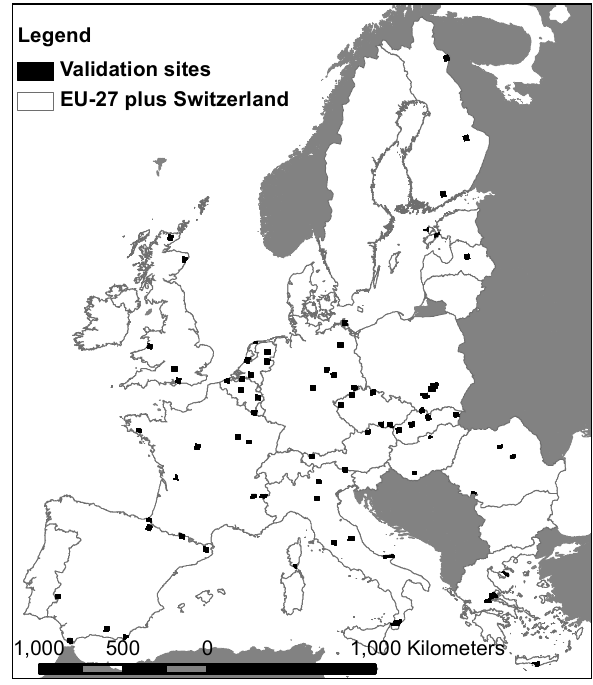
Fig. 3. Overview of validation sites for this